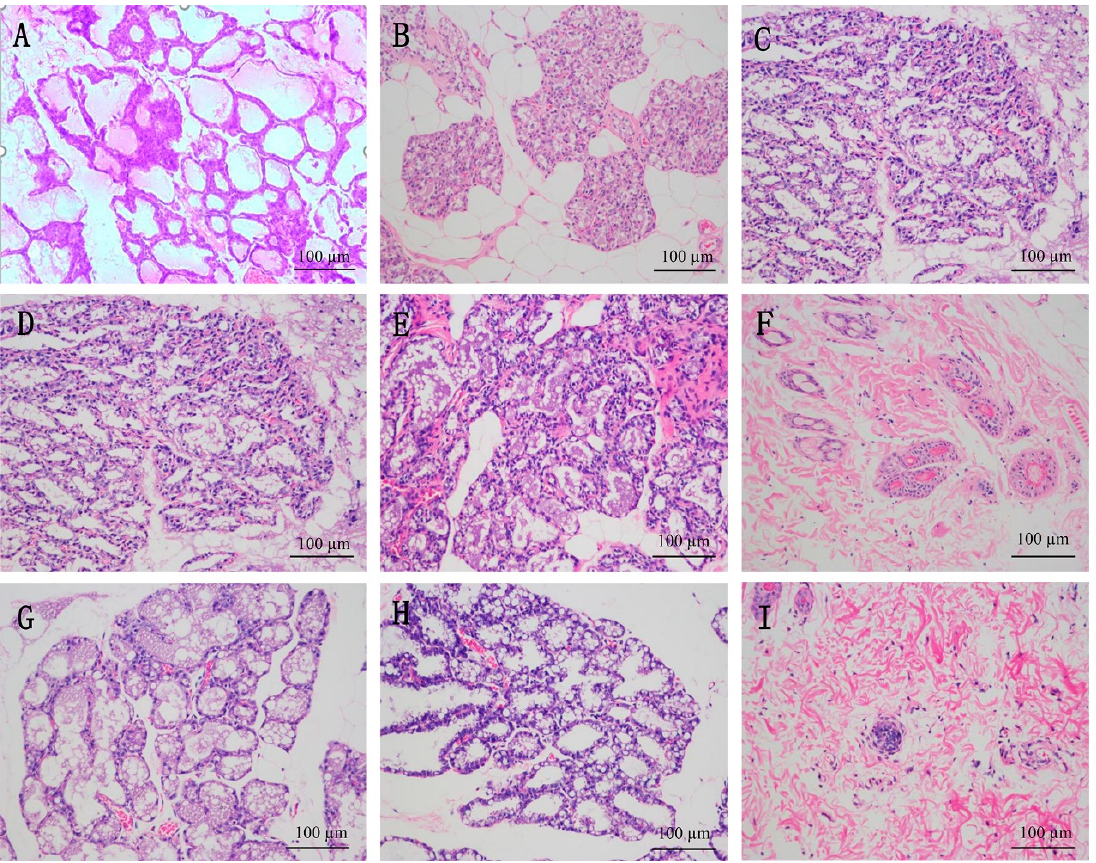
Figure 6. Mammary gland tissue in different groups of female rats under H&E staining; scale bars: 100 μ m. ( A ) Normal group (NG); ( B ) model group (MG); ( C ) Buxueshengmi granules group (BXSMG); ( D ) UEC4 high-dose group (UEC4-H); ( E ) UEC4 medium-dose group (UEC4-M); ( F ) UEC4 low-dose group (UEC4-L); ( G ) UEC4-1 high-dose group (UEC4-1-H); ( H ) UEC4-1 medium-dose group (UEC4-1-M); ( I ) UEC4-1 low-dose group (UEC4-1-L).